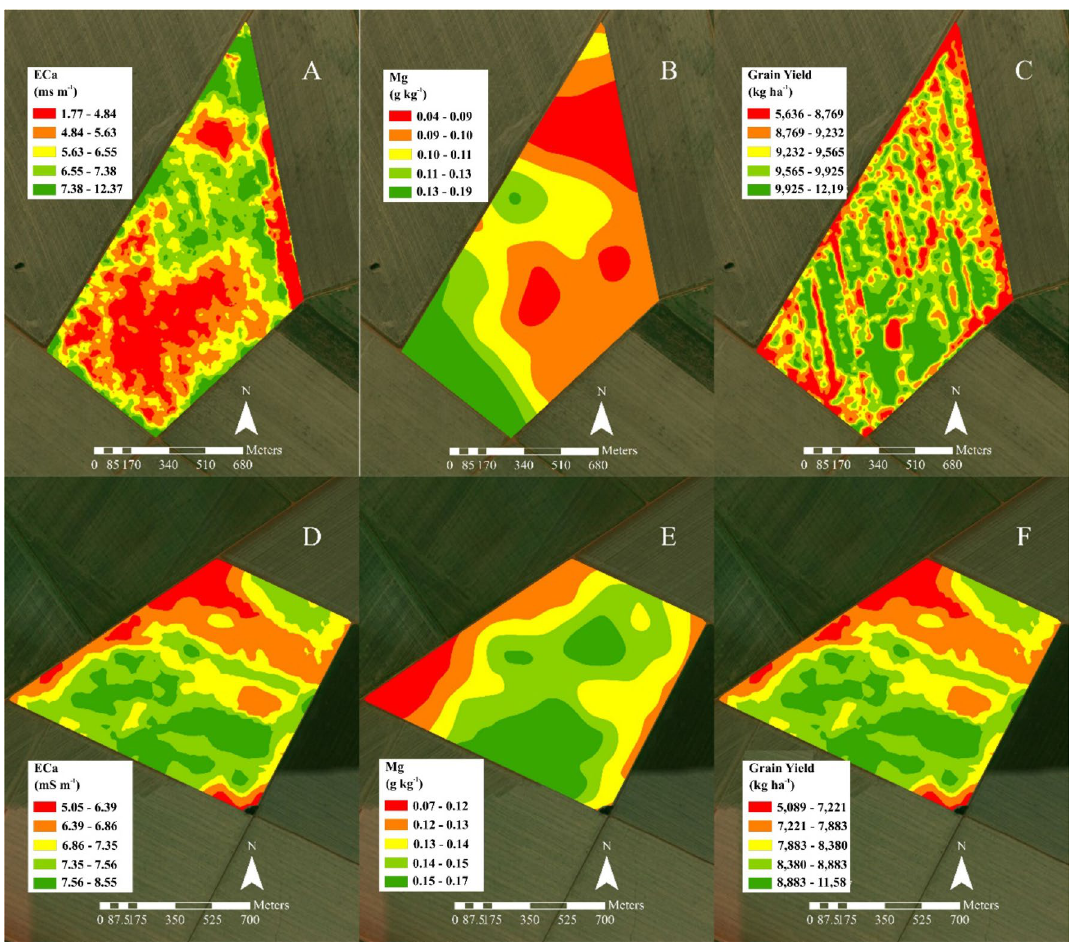
Figure 8. Maps of EC a ( A , D ) and Mg ( B , E ) used in the decision tree and grain yield (GY, C , F ) for sites B and C using VRS, respectively. The software used to create this figure was ArcGIS Desktop (v10.5, https:// deskt op. arcgis. com/ en/ system- requi remen ts/ 10.5/).